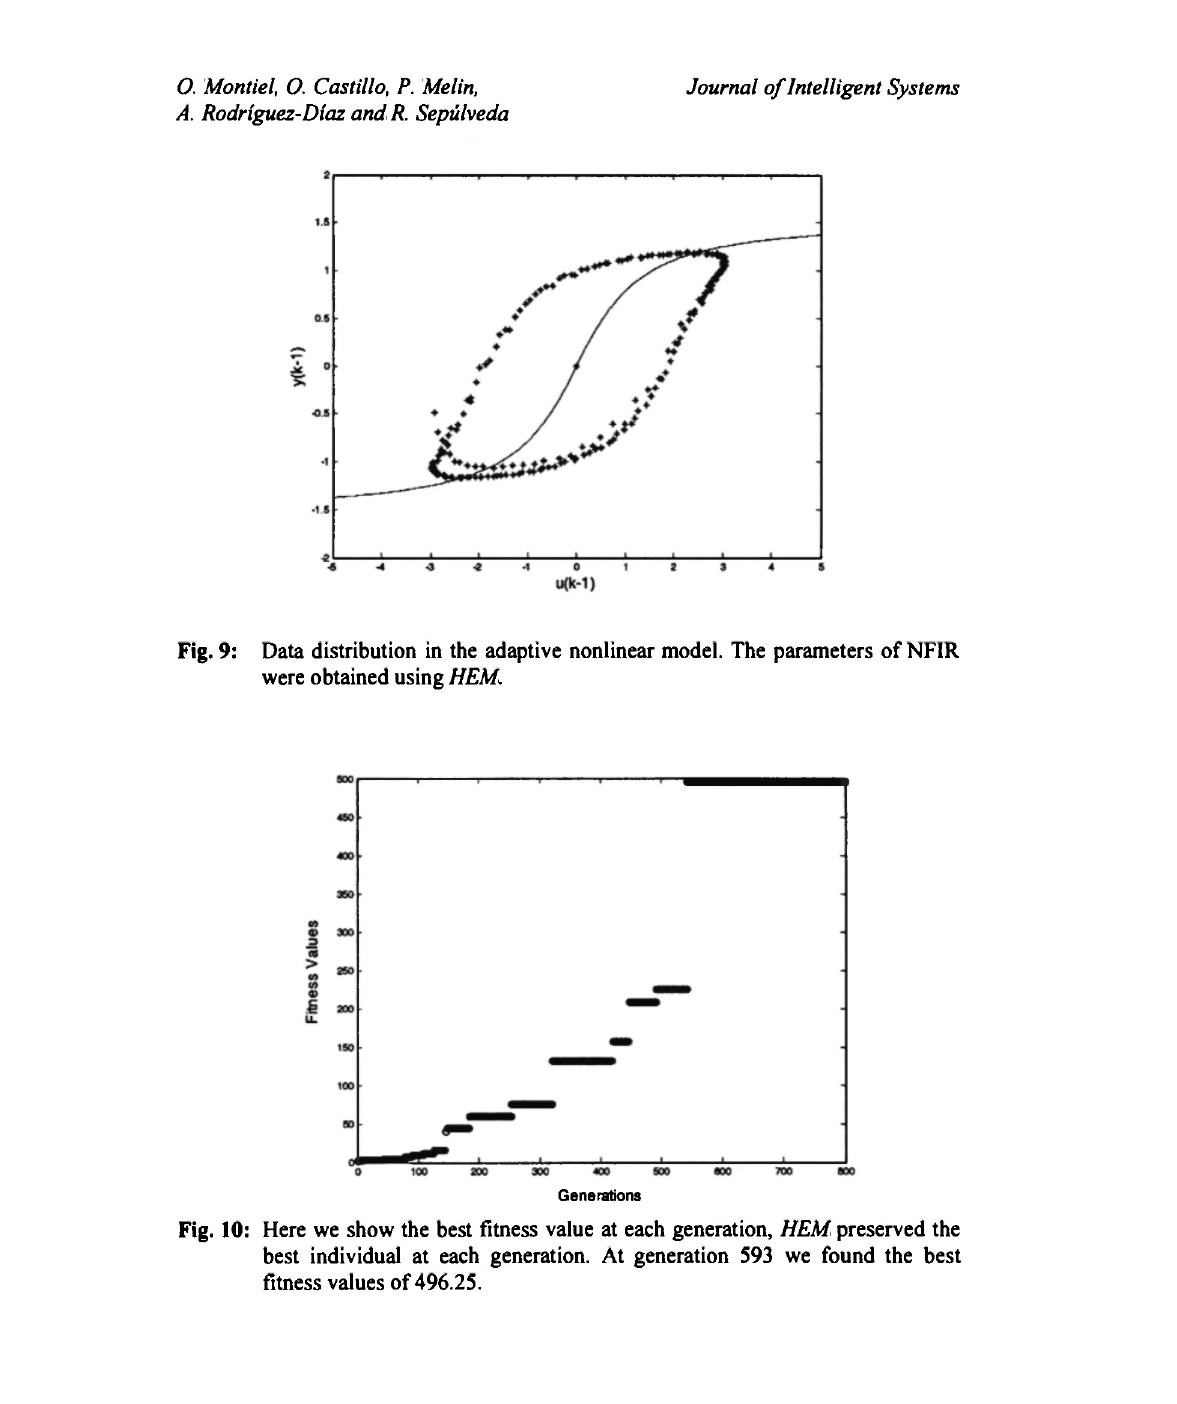
Fig. 10: Here we show the best fitness value at each generation, HEM preserved the best individual at each generation. At generation 593 we found the best fitness values of